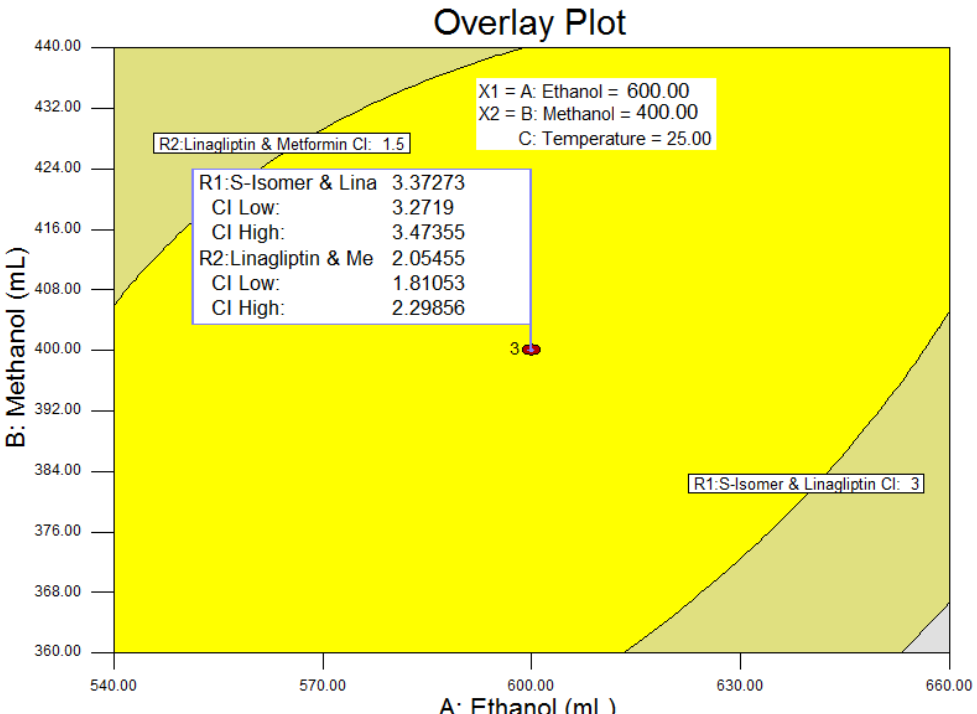
Figure 7. Overlay Plot with confidence interval (CI). Interpretation of the obtained results: ANOVA analysis, desirability and overlay plot. ANOVA: analysis of variance.